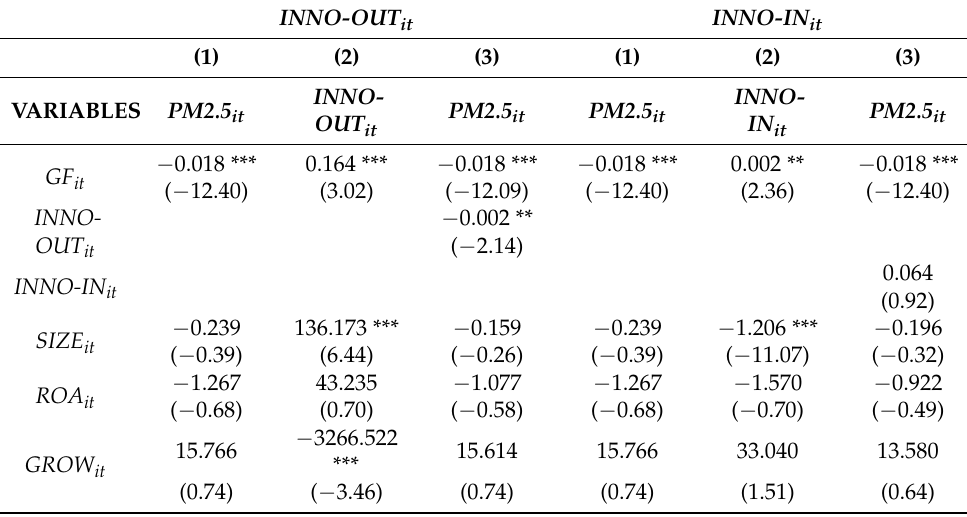
Table 4. The basic regression results of mediating